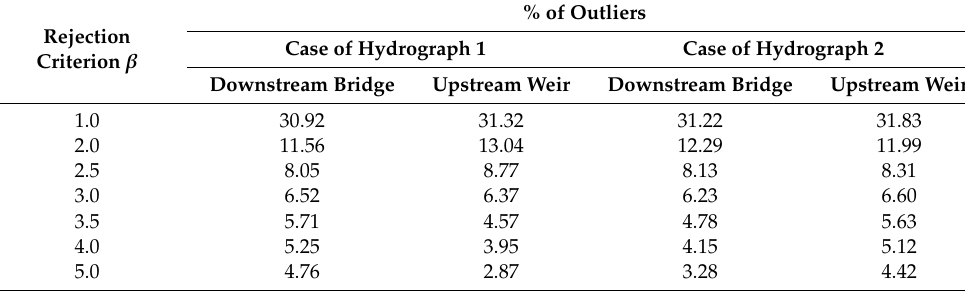
Figure 7. Relations between outlier percentage and rejection criterion.